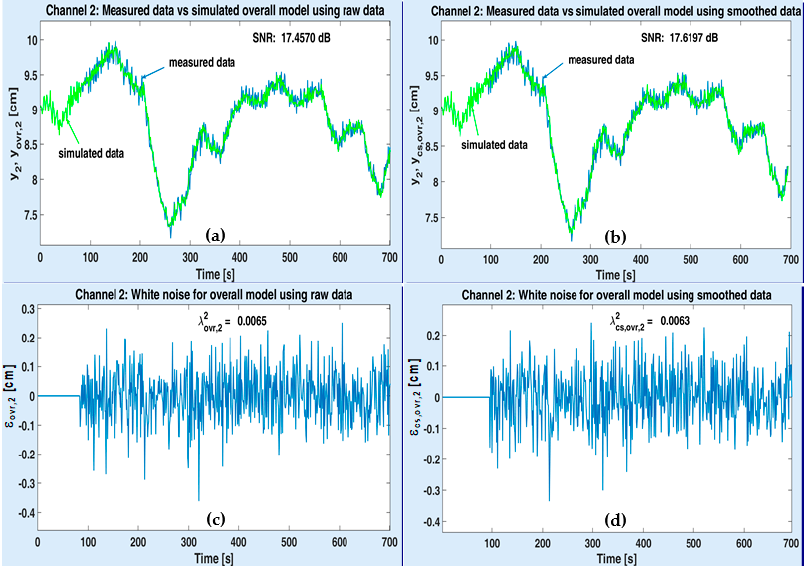
Figure 14. Performance of the optimal overall MISO model associated to ASTANK2 installation, on channel 2: measured versus simulated outputs with raw data ( a ) and smoothed data ( b ); estimated white noise from raw data ( c ) and smoothed data ( d ).